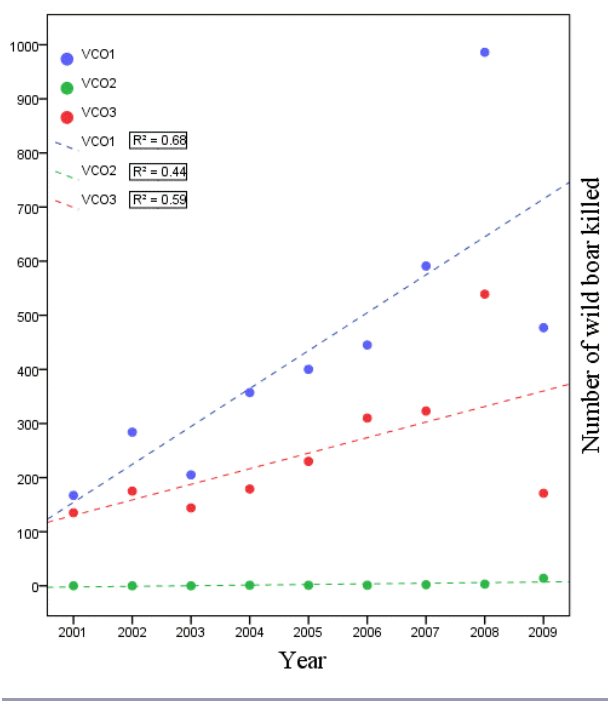
Fig. 3. Trend in the number of wild boar bagged over time from hunting activity in VCO1 and VCO3 hunting areas and from incidental take in VCO2 hunting area from 2001 to 2009. There is a clear increasing trend in VCO1 and VCO3, and virtually no take in